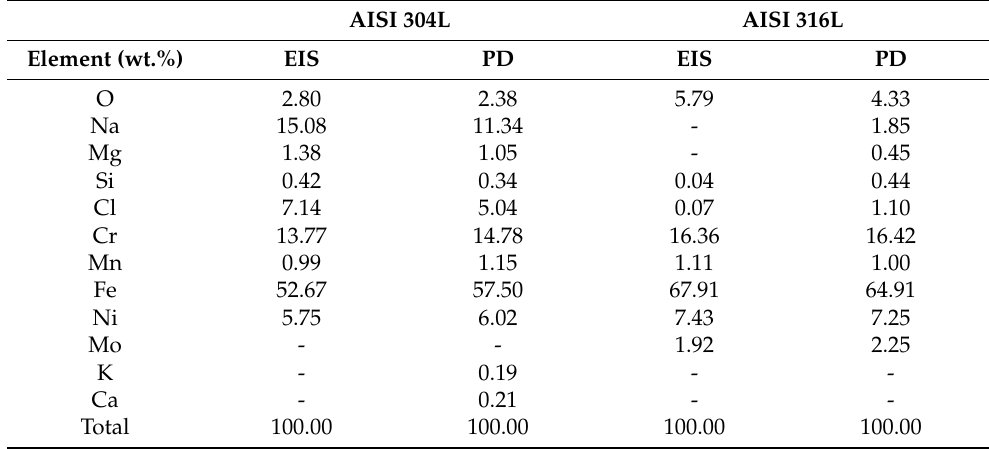
Table 6. Average elemental composition of the entire surface for AISI 304L and AISI 316L after impedance (EIS) and potentiodynamic polarization (PD) measurements in seawater at 298 K. AISI 304L AISI 316L Element (wt.%) EIS PD EIS PD O 2.80 Na